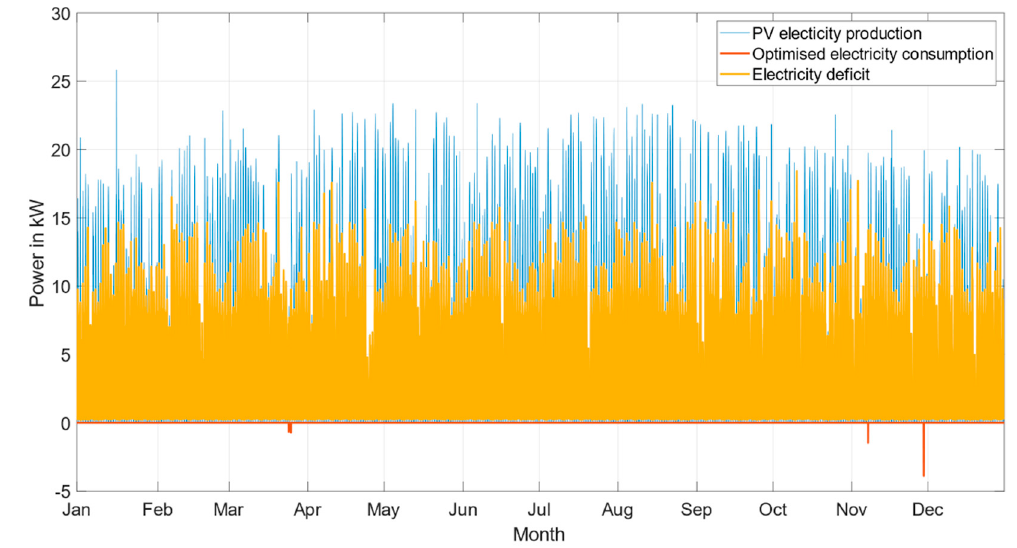
Figure 23. Hourly results after load shifting and optimization.